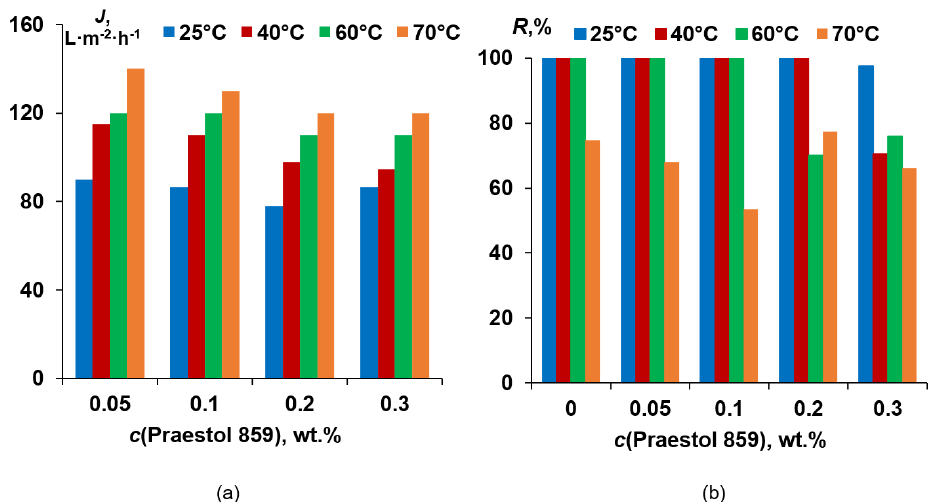
Figure 13. Human serum albumin (HSA) solution flux ( a ) and rejection ( b ) for PSF-based membranes vs. Praestol 859 concentration in the coagulation bath at different coagulation bath temperatures.